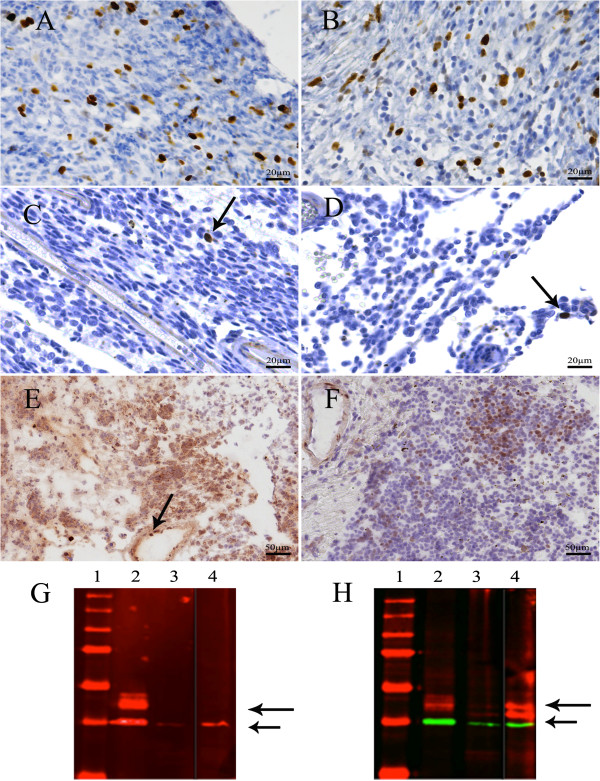
Pre- and posttreatment MIB-1 and pERK stains and Western Blot analysis. A and B. MIB-1 expression in the leptomeningeal melanocytosis sample before MEK162 treatment, in two hotspot regions (5% MIB-1-positive cells). C and D. The melanocytosis samples after MEK162 treatment showed lower MIB-1 expression than pre-treatment (<1% MIB-1-positive cells (arrows); compare with Figure 4A and B. C temporobasal brain and D frontobasal brain. E. pERK protein expression in the leptomeningeal melanocytosis before MEK162 treatment. Endothelial cells serve as a positive internal control (arrow). F. pERK protein expression after MEK162 treatment showing lower pERK expression than pre-treatment (compare with 4E). G and H. Western Blots showing expression of pERK (G) and total ERK (H) in the brain sample after MEK162 treatment (lane 4), along with Rh-18 and Granta-519 as positive and negative controls in lanes 2 and 3, respectively. In the brain sample, pERK cannot be detected after MEK162 treatment (G), whereas total ERK is present (H), as indicated by the long arrows. Short arrows indicate GAPDH expression.